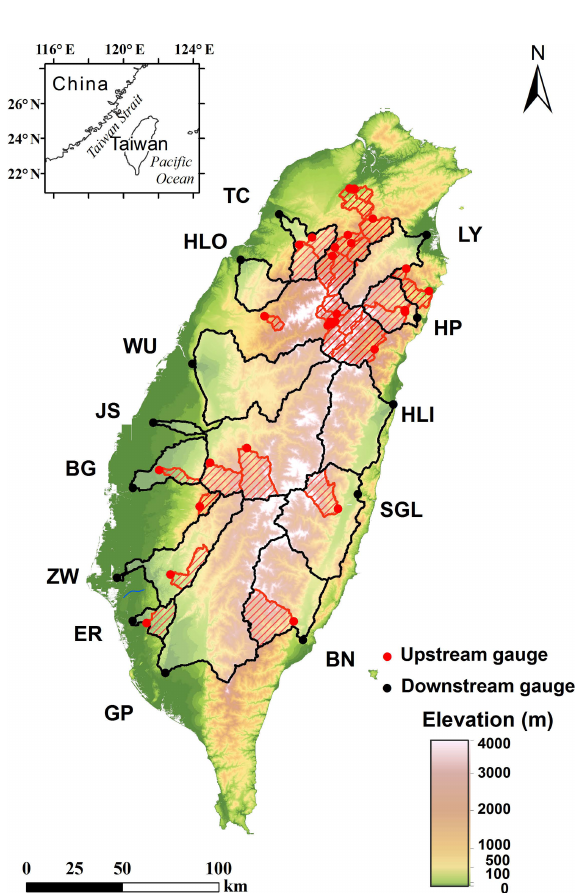
Figure 1. Thirteen major watersheds (black boundaries with abbre- viations near the outlets) of Taiwan and 28 upstream catchments (red shadings) analysed in this